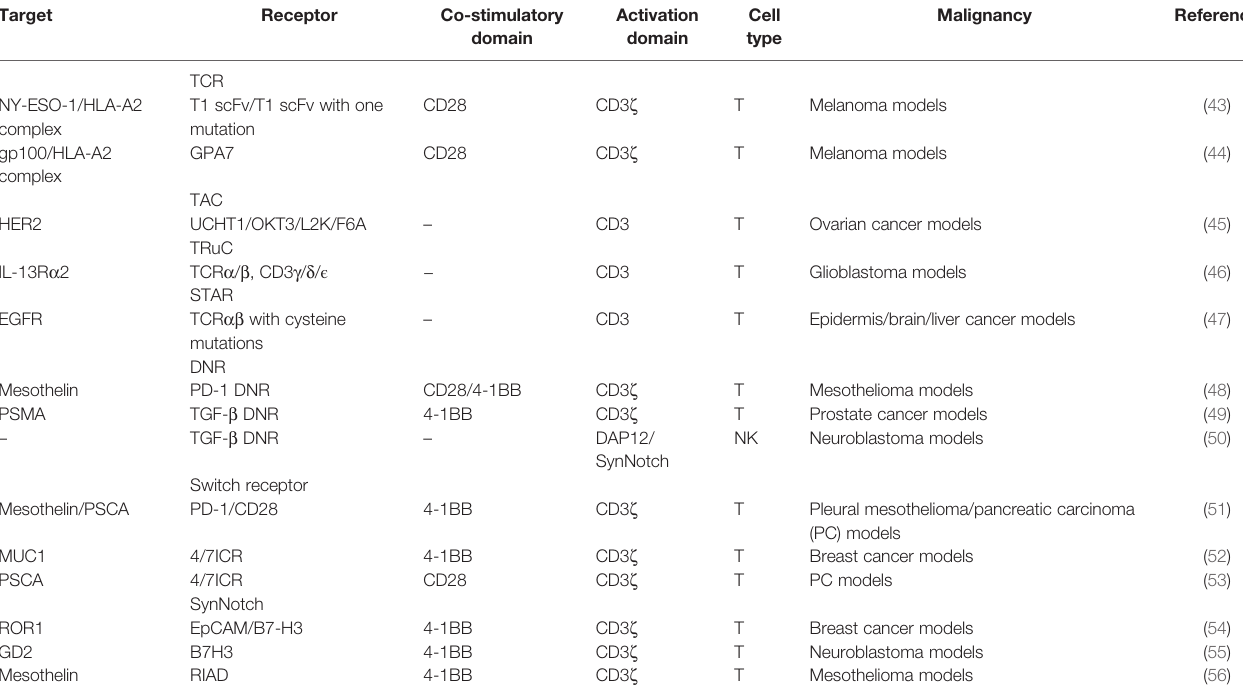
TABLE 2 | CARs with different receptors and modi fi cations in solid tumors.